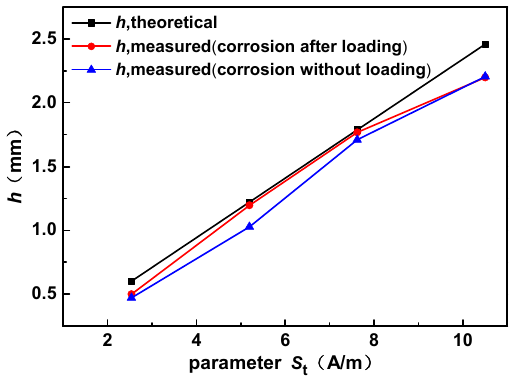
Figure 16. Comparison between measured and theoretical values of the corrosion depth h .